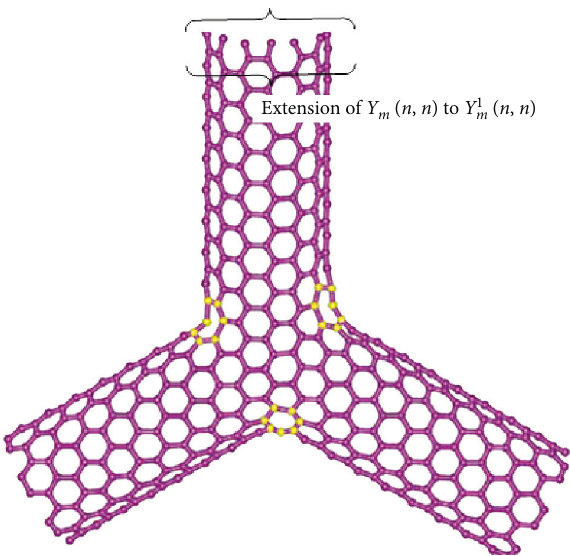
Figure 2: A variant of Y -junction Y 1